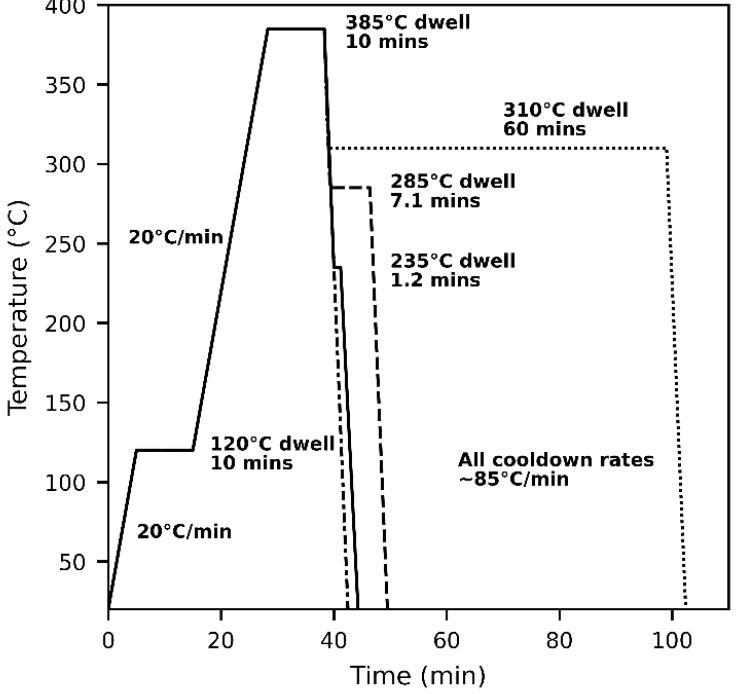
Figure 3. Heat cycle used for four processes: Three isothermal dwells at 310 ◦ C, 285 ◦ C, and 235 ◦ C and one constant cooldown at 85 ◦ C/min. Dwells were held until full crystallization.